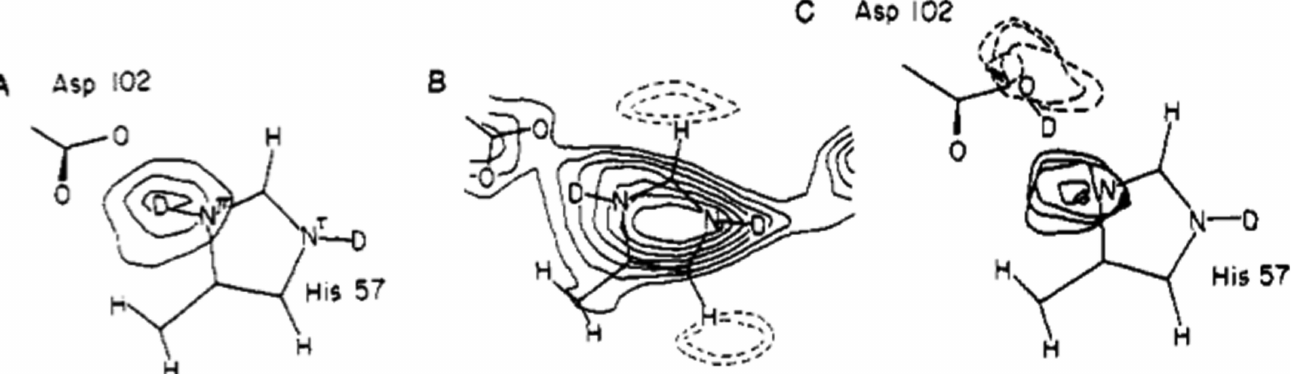
Figure 2 Nuclear density map showing protonation of His57 in trypsin. Left, difference density map showing protonation of N (cid:5) of His57. Center, 2 F o (cid:2) F c nuclear density map with double protonation of His57 and negative density peaks for the unexchanged H atoms. Right, difference density map with the proton modeled on Asp102. The contour shows that the proton belongs on His57 (solid lines) and not Asp102 (dotted lines). Reprinted with permission